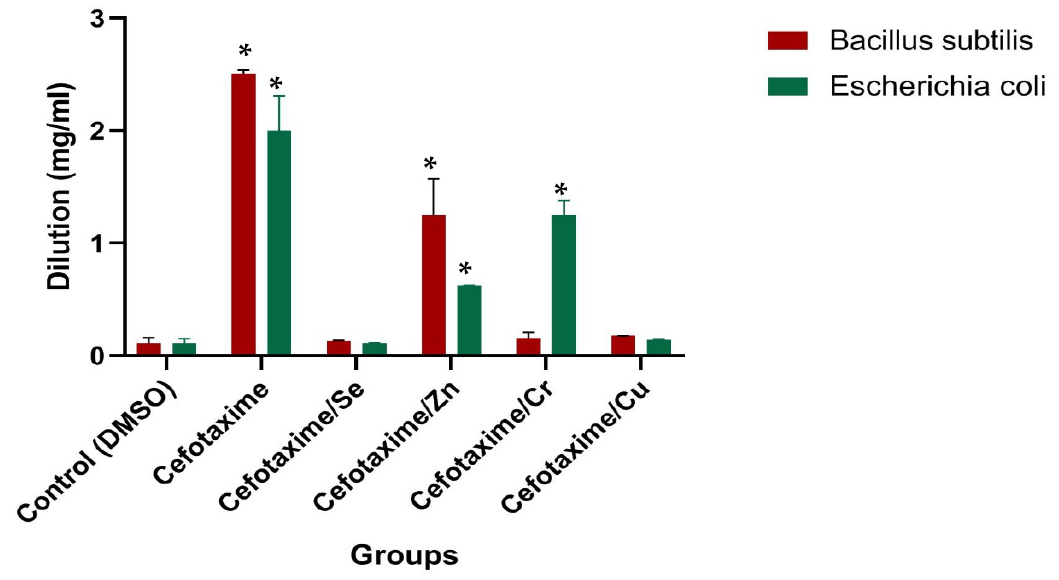
Figure 12. Antibacterial activity of cefotaxime and cefotaxime metal complexes, Results are expressed as mean ± SE. (*) p ≤ 0.05 vs. cefotax group.